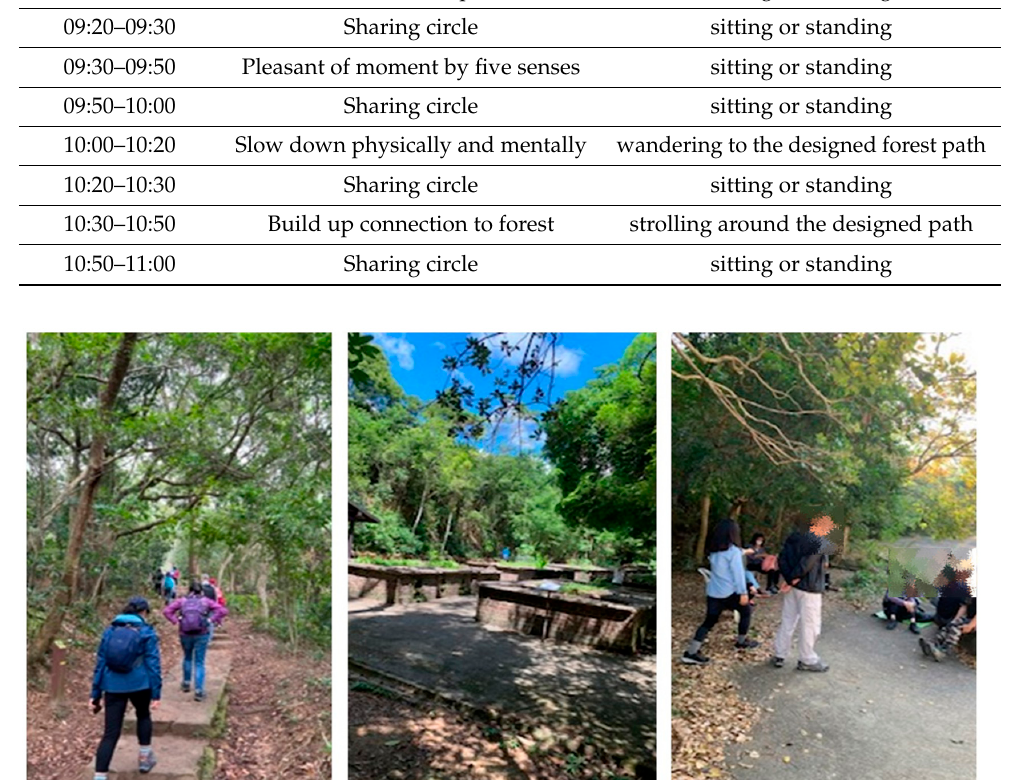
Table 1. Schedule of each forest visit.